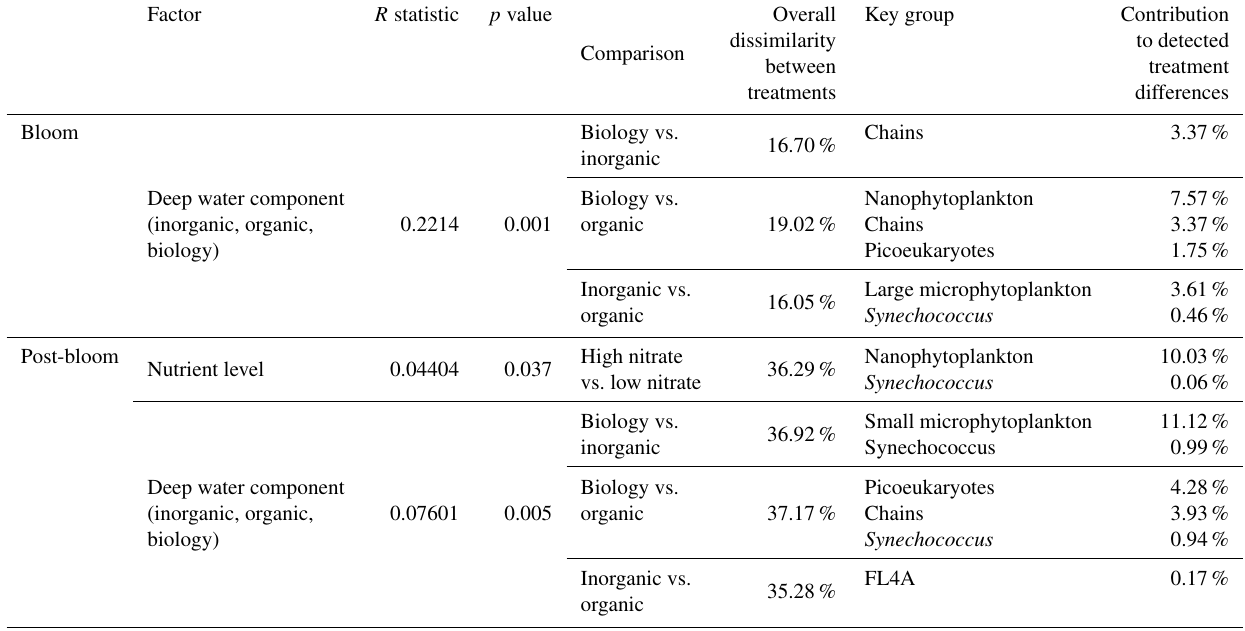
Table 3. Results of one-way ANOSIM analyses and post hoc SIMPER analyses reporting only on the significant differences in measured cell abundances, where detected, and the groups with the highest and significant contribution to these treatment differences. Bloom phase is defined here as Day 3 and Day 4, and post-bloom is defined as Day 8 to Day